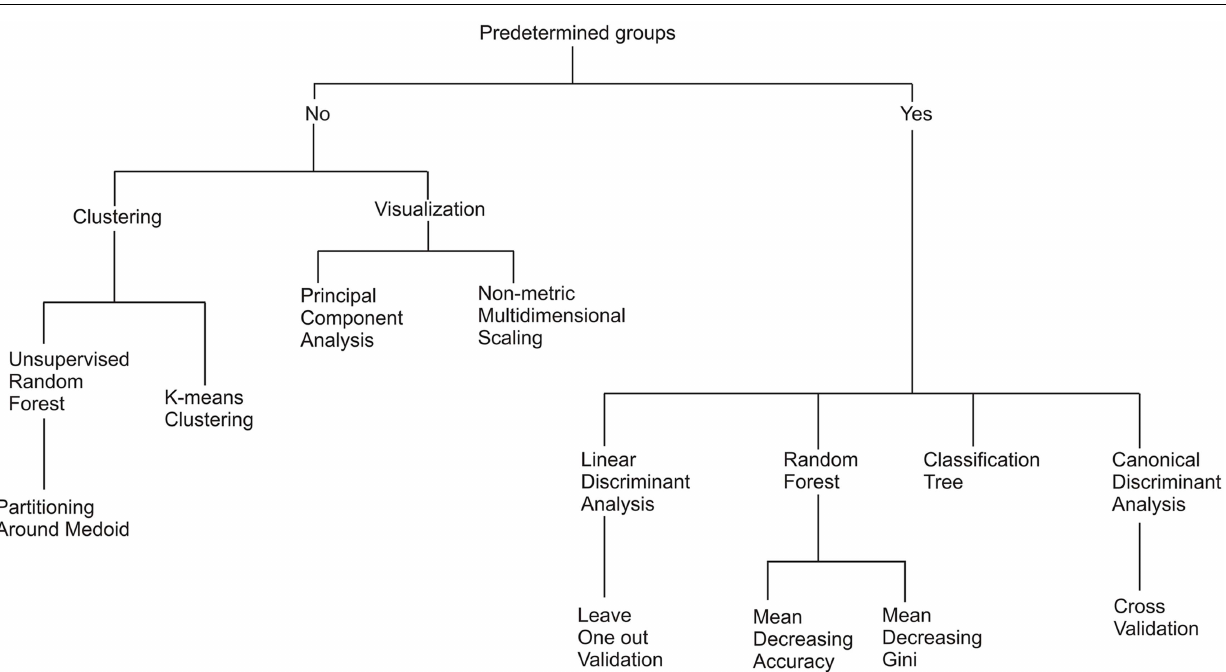
sampled environment to determine the discriminating power of the